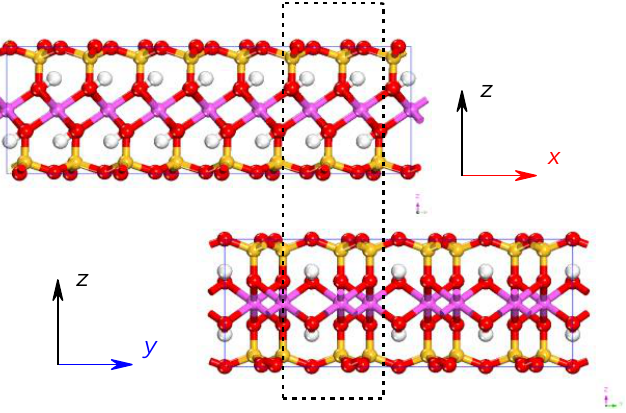
strength in the mineral plane is much higher than that of non-bonding strength between mineral lamellae.